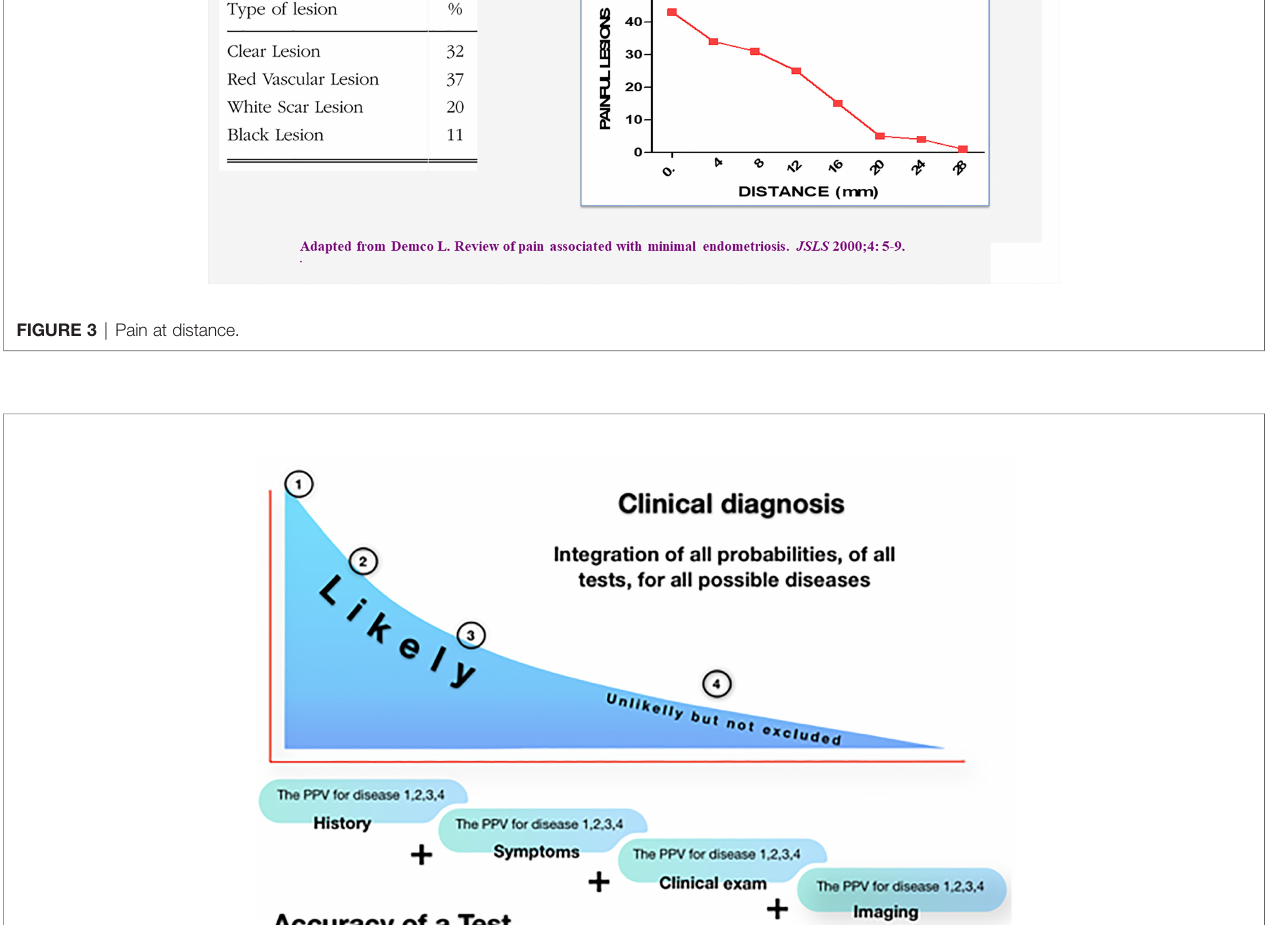
FIGURE 4 | The Clincal diagnosis is an art. History, symptoms, clinical exam and imaging are combined by the clinician into a series of probabilities for the many potential diagnoses. This integration aided by experience could theoretically be replaced by the calculation of the combined predictive values, with their margins of error and con fi dence limits, of each test for each potential